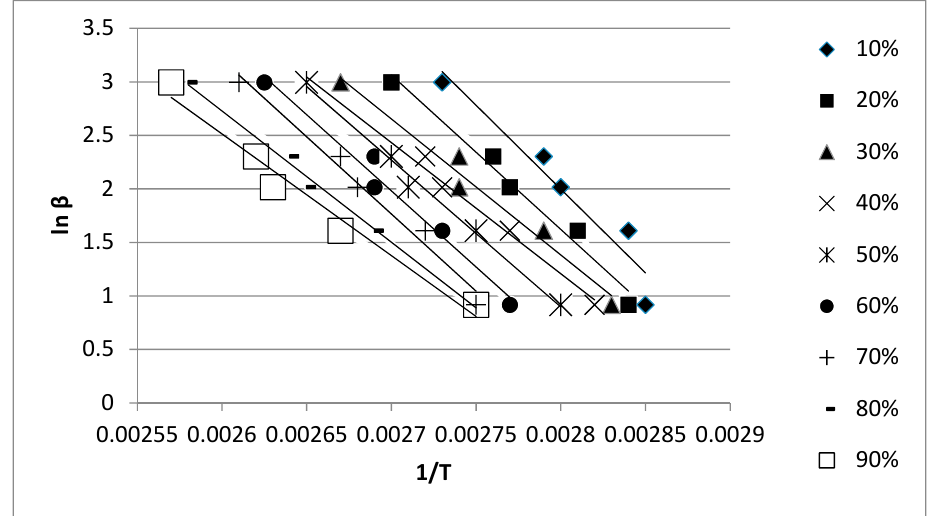
Figure 2. Flynn–Wall–Ozawa linear dependencies for the copolymerization process between D-mannose Figure 2. Flynn – Wall – Ozawa linear dependencies for the copolymerization process between D- oligomer and 2-hydroxypropyl acrylate (weight ratio mannose oligomer and 2-hydroxypropyl acrylate (weight ratio 1:2).